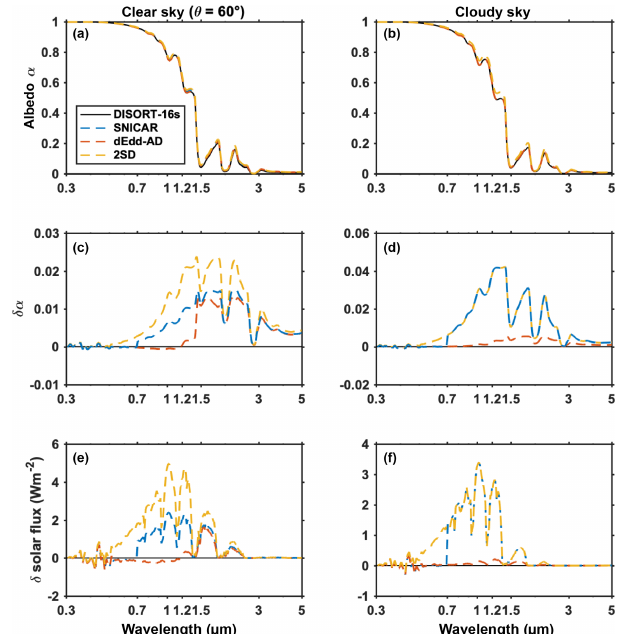
Figure 2. The spectral albedo of pure snow computed using 16- stream DISORT, SNICAR, dEdd–AD, and 2SD models, for clear- sky (direct beam at solar zenith angle 60 ◦ ) and cloudy-sky condi- tions in the left and right panels, respectively. Panels (a, b) show spectral albedo. Panels (c, d) show the difference ( δα = α 2 − α 16 ) in spectral albedos computed using the two-stream model ( α 2 ) and 16-stream DISORT ( α 16 ). Panels (e, f) show the difference of re- flected spectral flux given δα . The snowpack is set to semi-infinite deep with a grain radius of